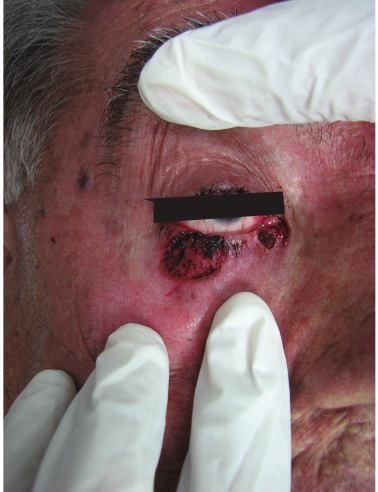
Figure 2: Induced defects after laser therapy.